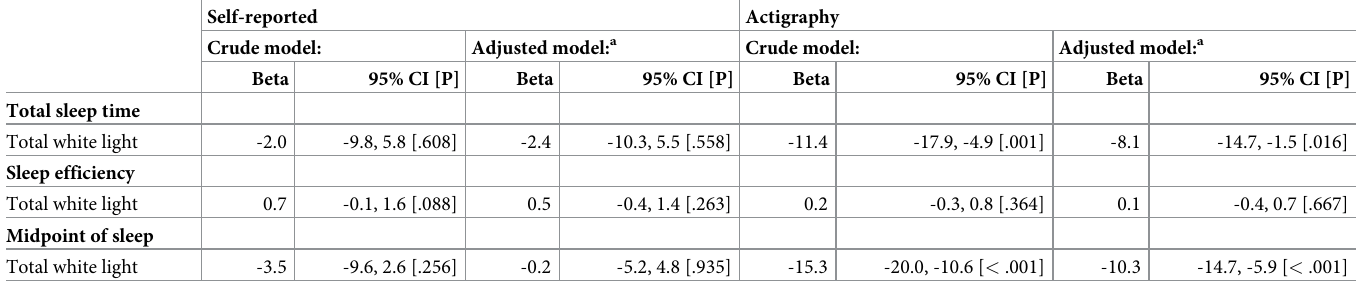
Table 4. Association between sleep and evening light exposure in pregnant